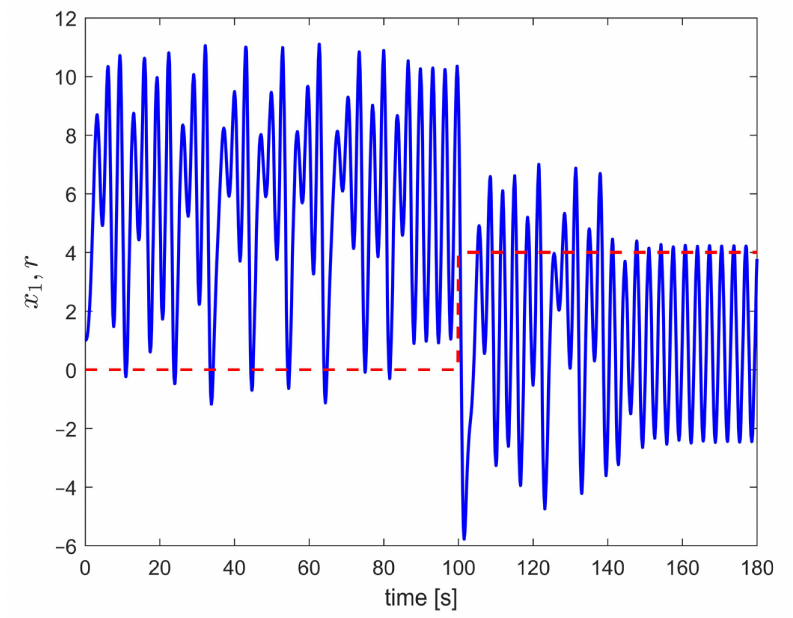
Figure 2. Evolution of signals x 1 (solid line) and r (dashed line) for initial condition x = [ 1 0 0 ] T